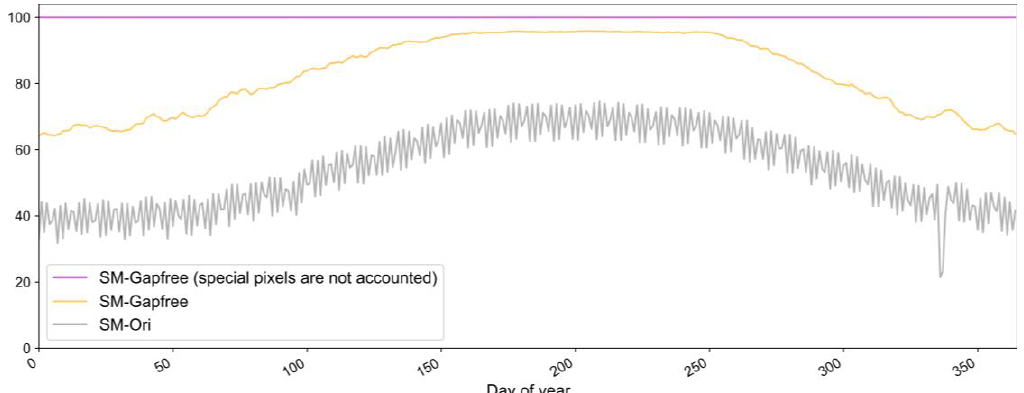
Figure 6. Global average of fractional valid data (with daily step) in 2015: the daily NN-SM product (grey line), the reconstructed gap-free product (orange line), and reconstructed gap-free product if the special pixels (i.e., permanent snow/ice, frozen soil and water) are not accounted (magenta line).